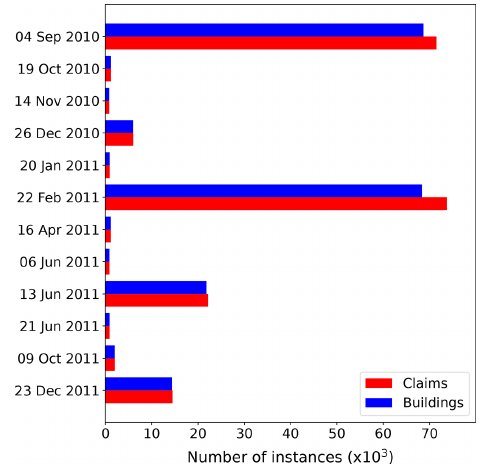
Figure 2. Number of claims and property for events in the CES after filtering for ClaimStatus. Only events with more than 1000 instances prior to cleansing are